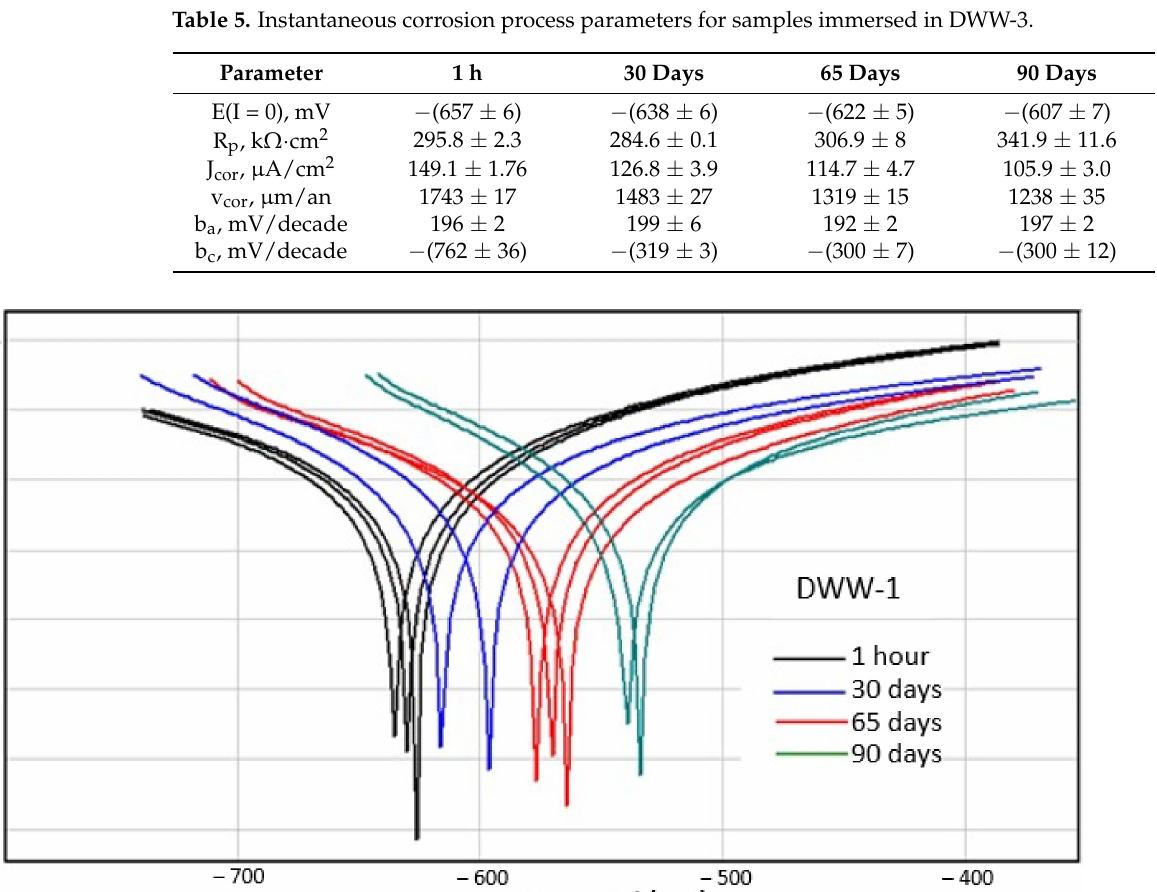
Figure 1. Polarisation curves for nodular cast-iron immersed at various time intervals in